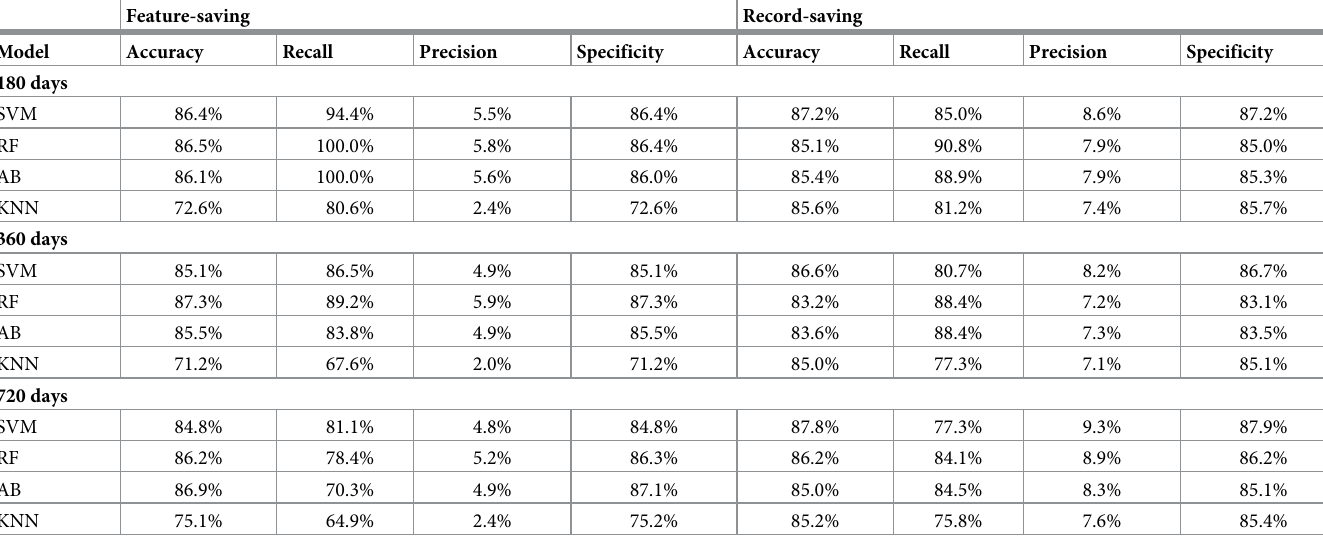
Table 4. Results of Visit-Oriented models on Feature-saving and Record-saving datasets at different time points. Feature-saving